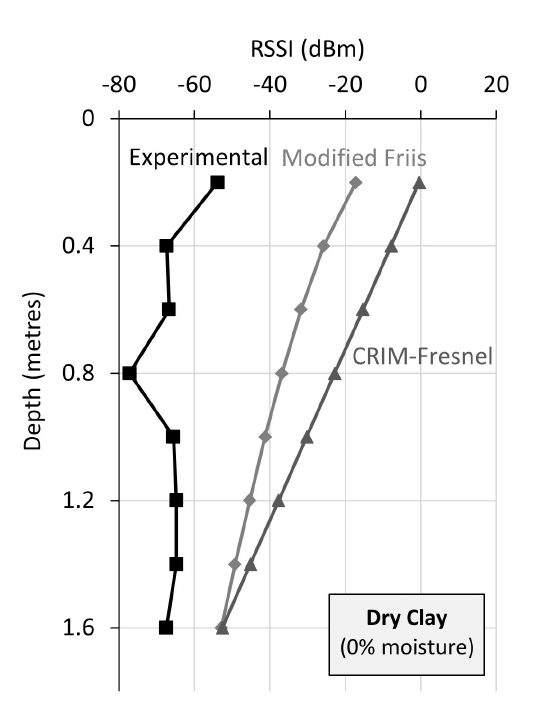
Figure 5. LoRa signal strength in dry clay at depths 0.2 to 1.6